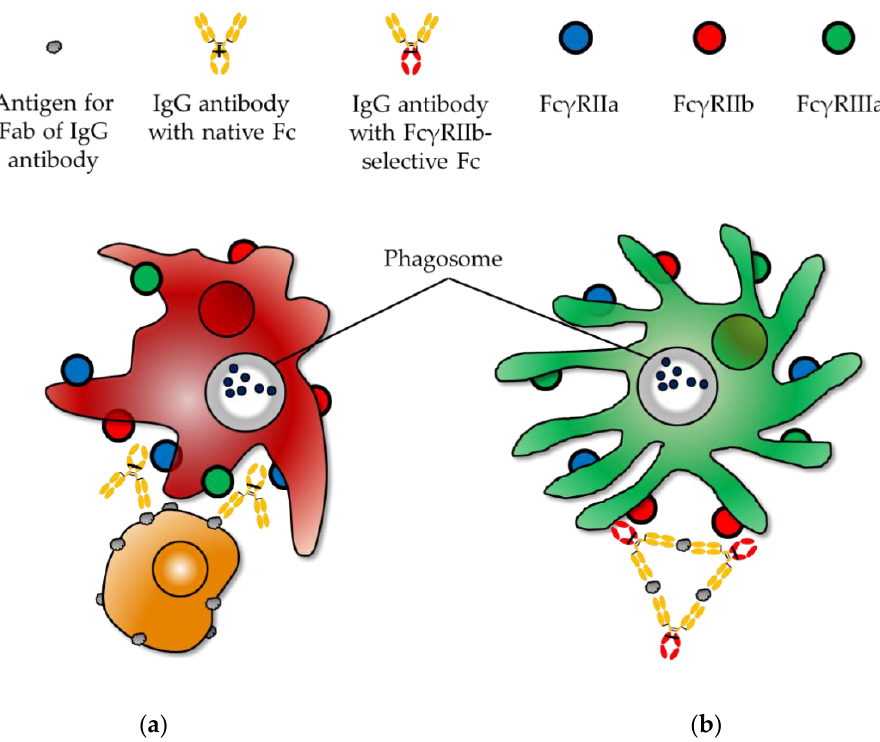
Figure 3. To elucidate Fc function, FcγR-selective Fc should be present. ( a ) Native IgG antibodies engage all types of FcγRs, making it very difficult to dissect the function of each FcγR in macrophages until the FcγR-selective IgG antibody is present; ( b ) FcγRIIb function in dendritic cells can only be clarified in the presence of FcγRIIb-selective IgG antibody.